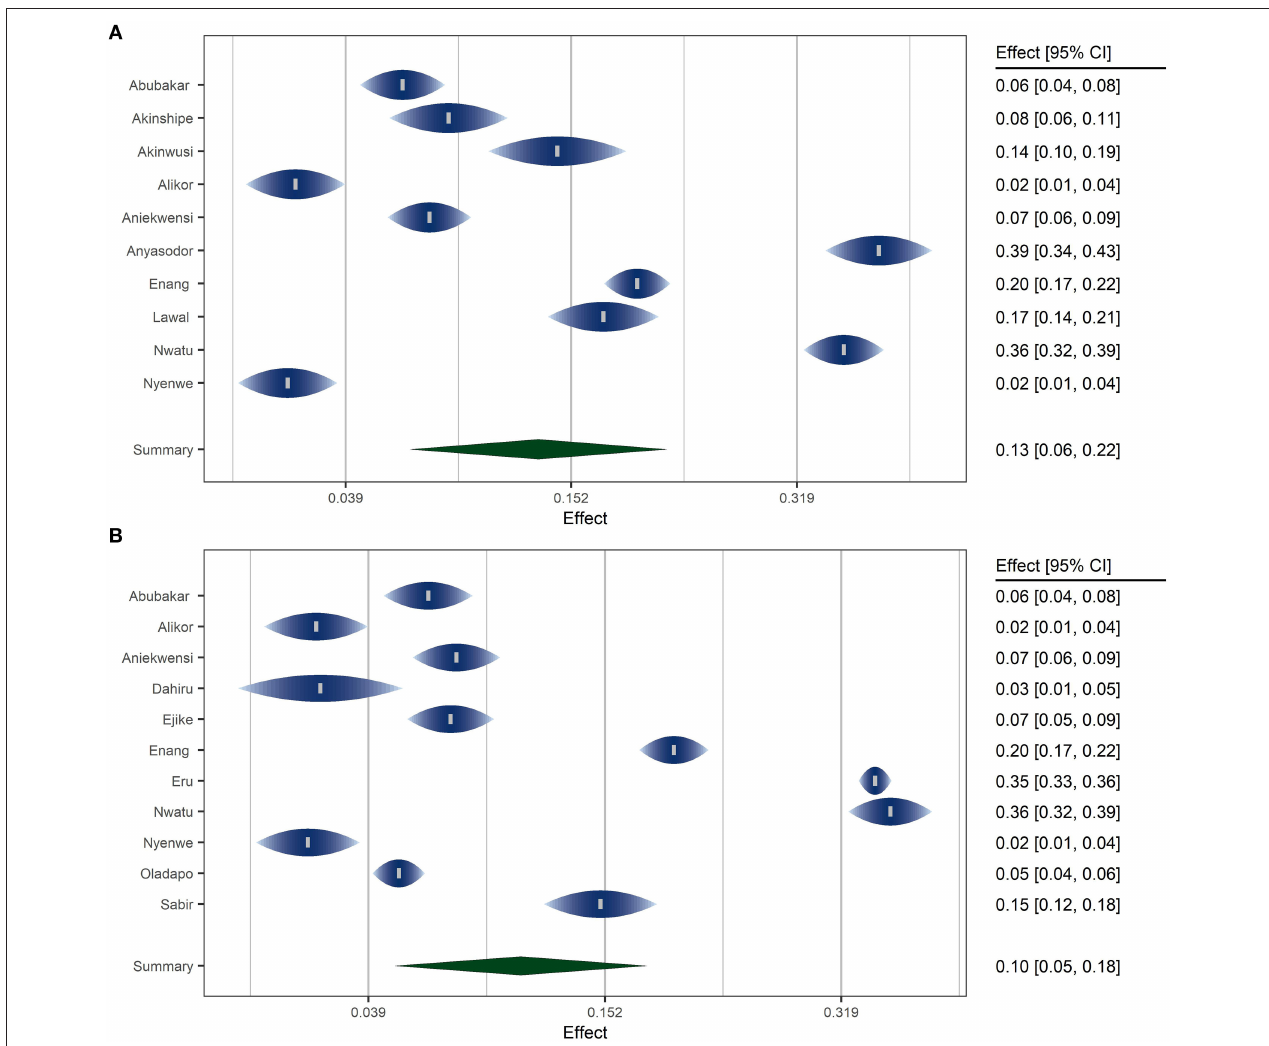
FIGURE 4 | Forest plots of Studies using ADA [plot (A) ] and WHO [plot (B) ] Criteria.